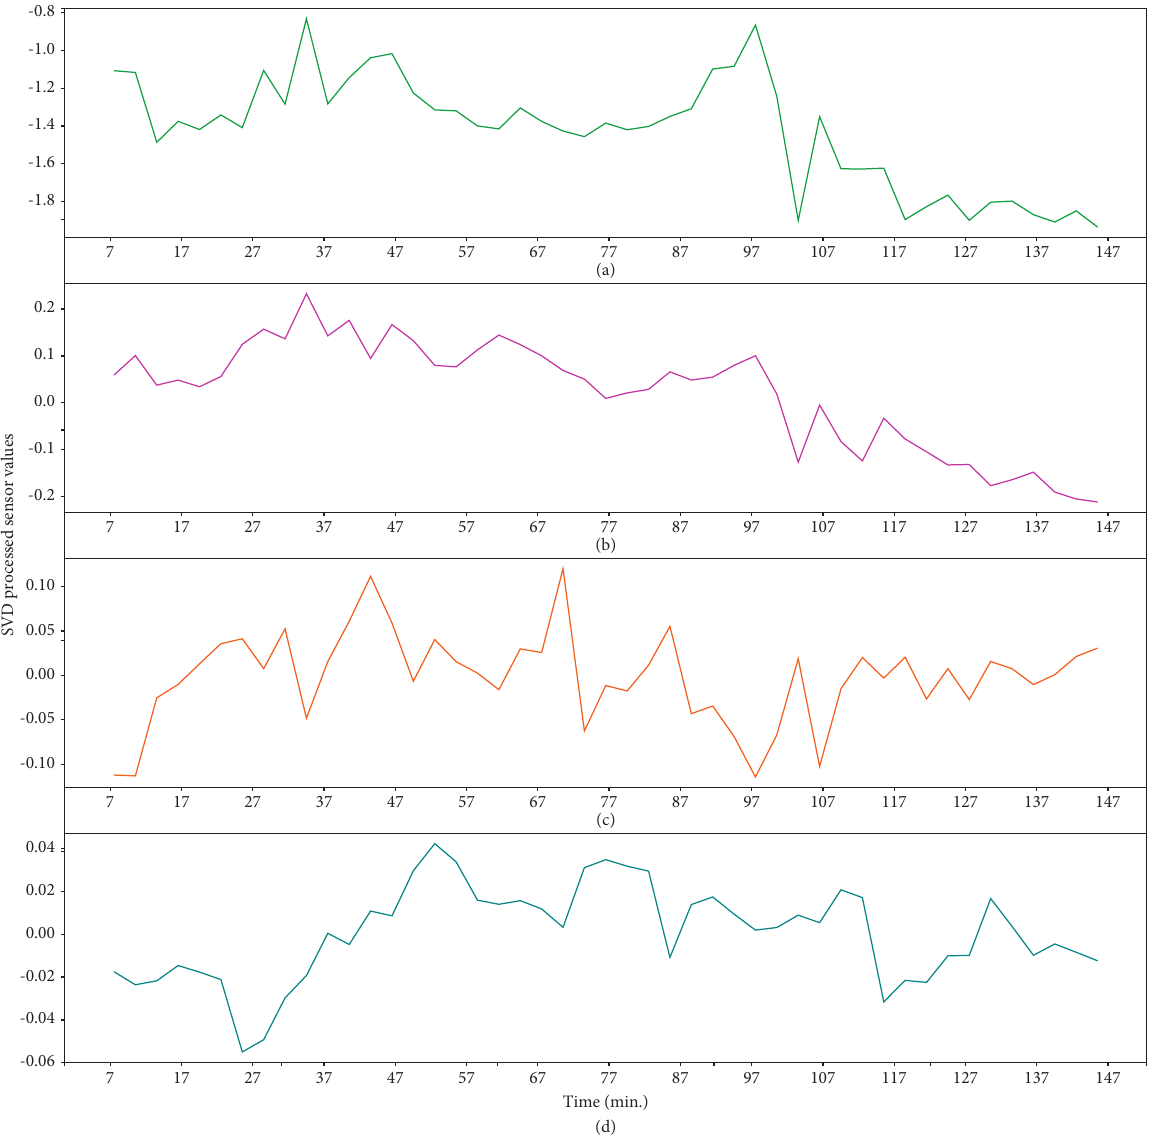
Figure 4: Sample of SVD-processed sensor data (comparing level): (a) MQ2; (b) MQ3; (c) MQ4; and (d)